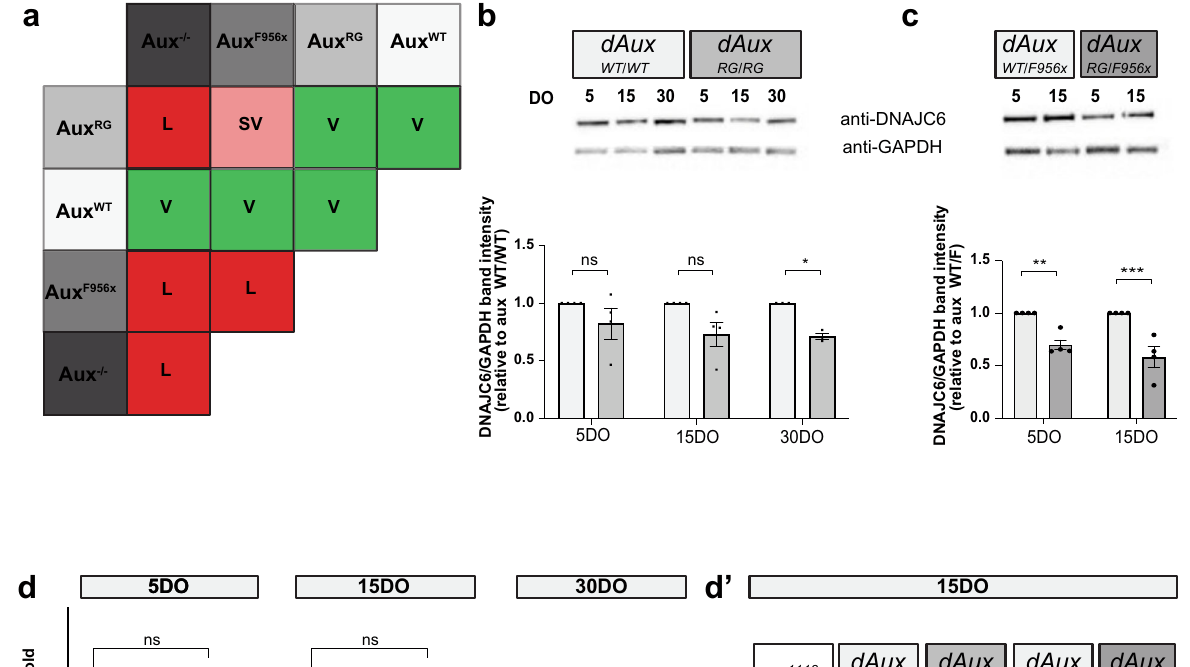
dAux RG/RG (Fig. 2b, c). This further con fi rms that R1119G is a weak hypomorpic mutant and that it leads to a small age-dependent decline in protein abundance. We next asked if the mutant dAux fl ies display progressive neurological problems, including motor defects and